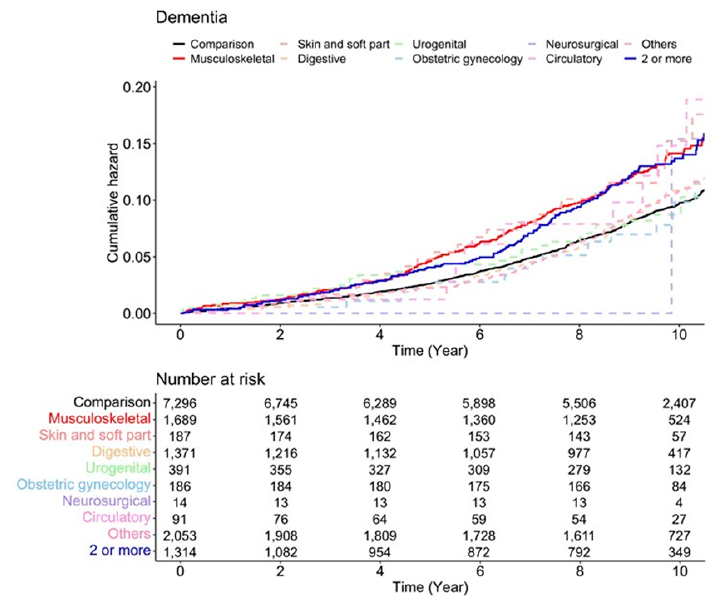
Figure 2. Risk of development of dementia according to surgery type.